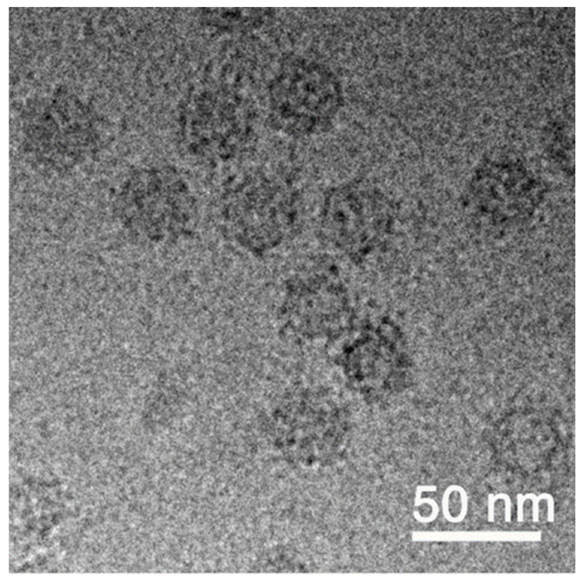
Figure 2. Visualization of RGNNV VLPs by